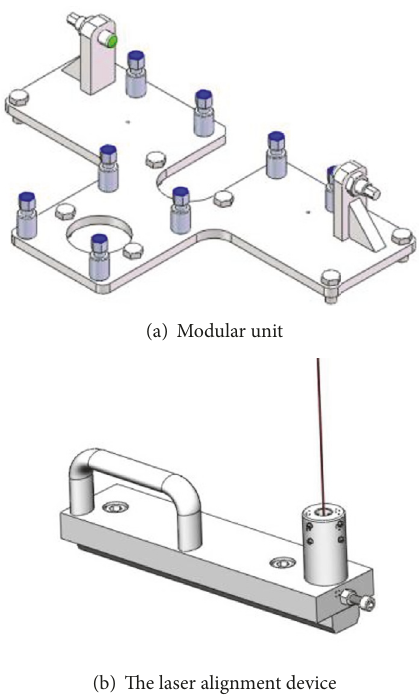
Figure 3: The functional unit of fixture.